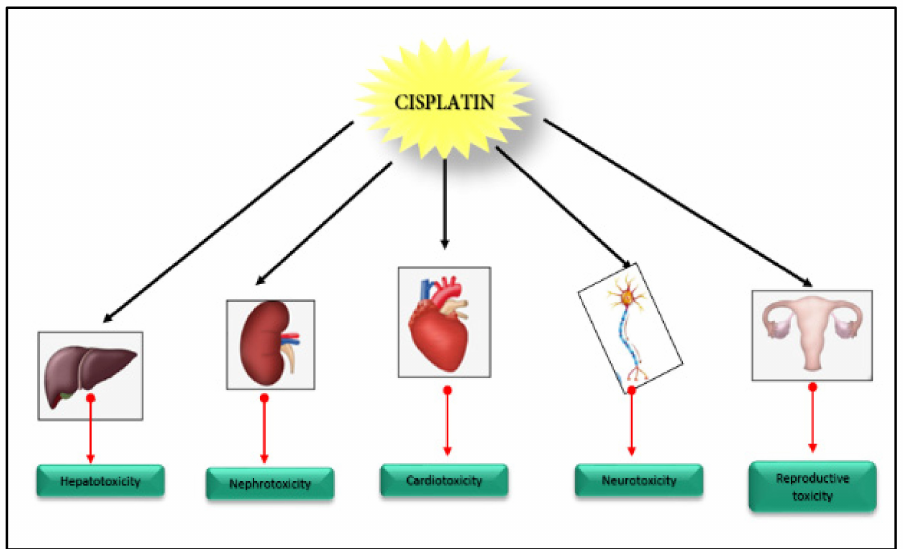
Figure 3. The current understanding of cisplatin chemotherapy-induced